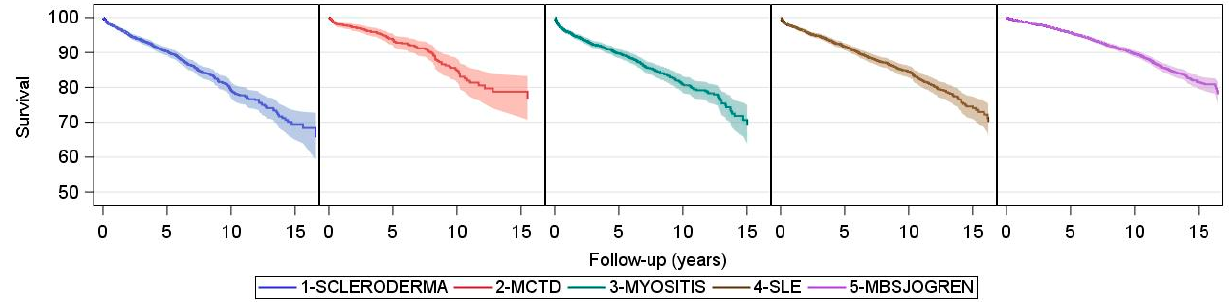
Figure 3. Survival in CTD. Kaplan–Meier survival curves for each CTD subtype with adjustment for age. Time origin is the date of CTD diagnosis. Shaded areas represent 95% confidence intervals.